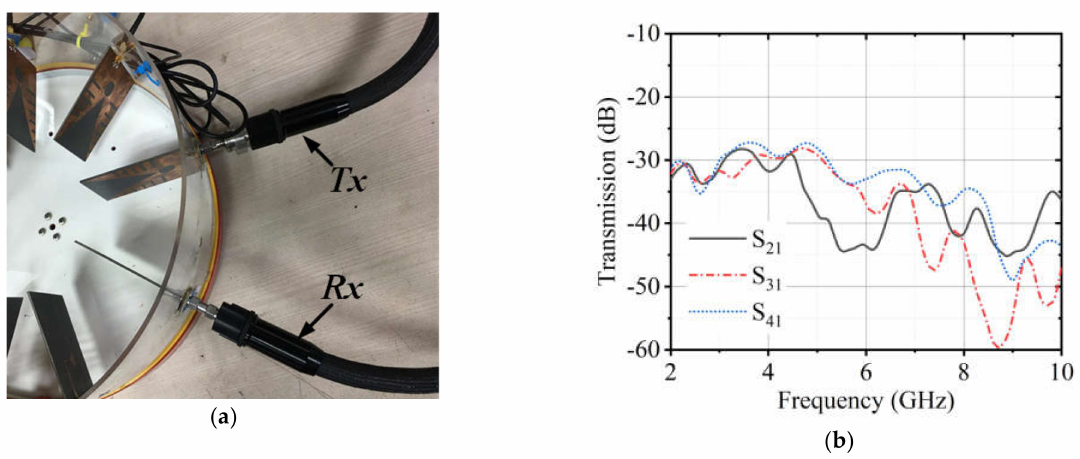
Figure 5. ( a ) Mutual coupling measurements set up with adjacent antennas ( b ) Transmission